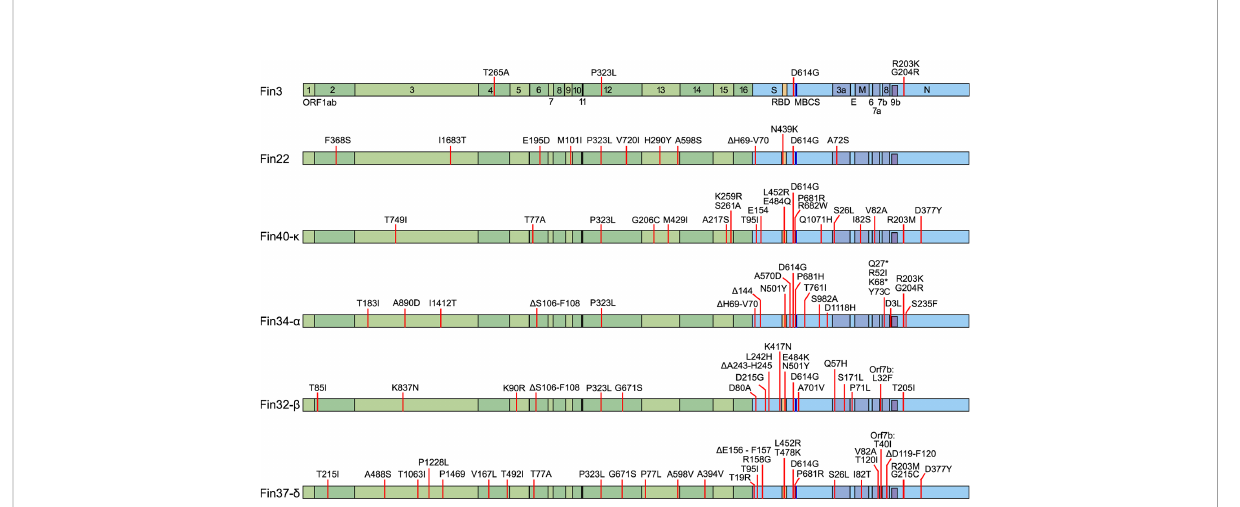
FIGURE 1 Mutations in the six pre-Omicron SARS-CoV-2 variants used to infect Calu-3 cells. The mutations are mapped against the hCoV-19/Wuhan/ WIV04/2019 reference genome (EPI_ISL_402124). In green are the non-structural proteins located in Orf1ab and in blue are the structural proteins S, E, M, N, and accessory proteins. Receptor-binding domain (RBD, S protein amino acid residues 437-507, orange), multi-basic cleavage site (MBCS, S protein amino acid residues 681-685, (P-R-R-A-R), dark blue) are also